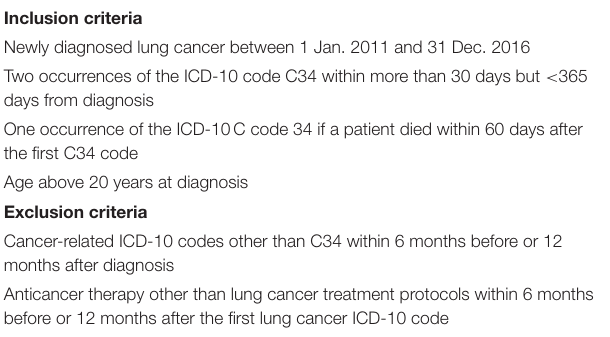
TABLE 1 | Inclusion, exclusion